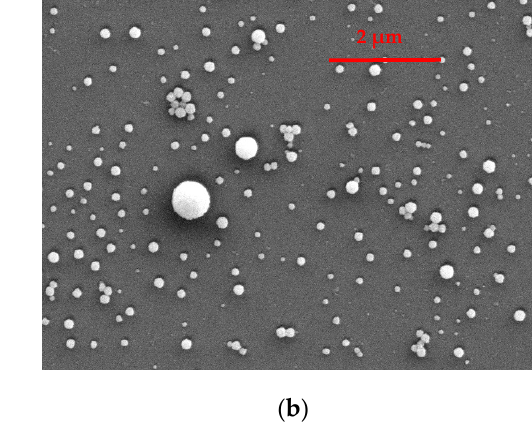
Figure 4. ( a ) Particle size and zeta potential as function of pH value; ( b ) SEM image of protected particles deposited on a PEI-coated silicon wafer. Measured particle size 133 ± 27 nm ( n > 100).